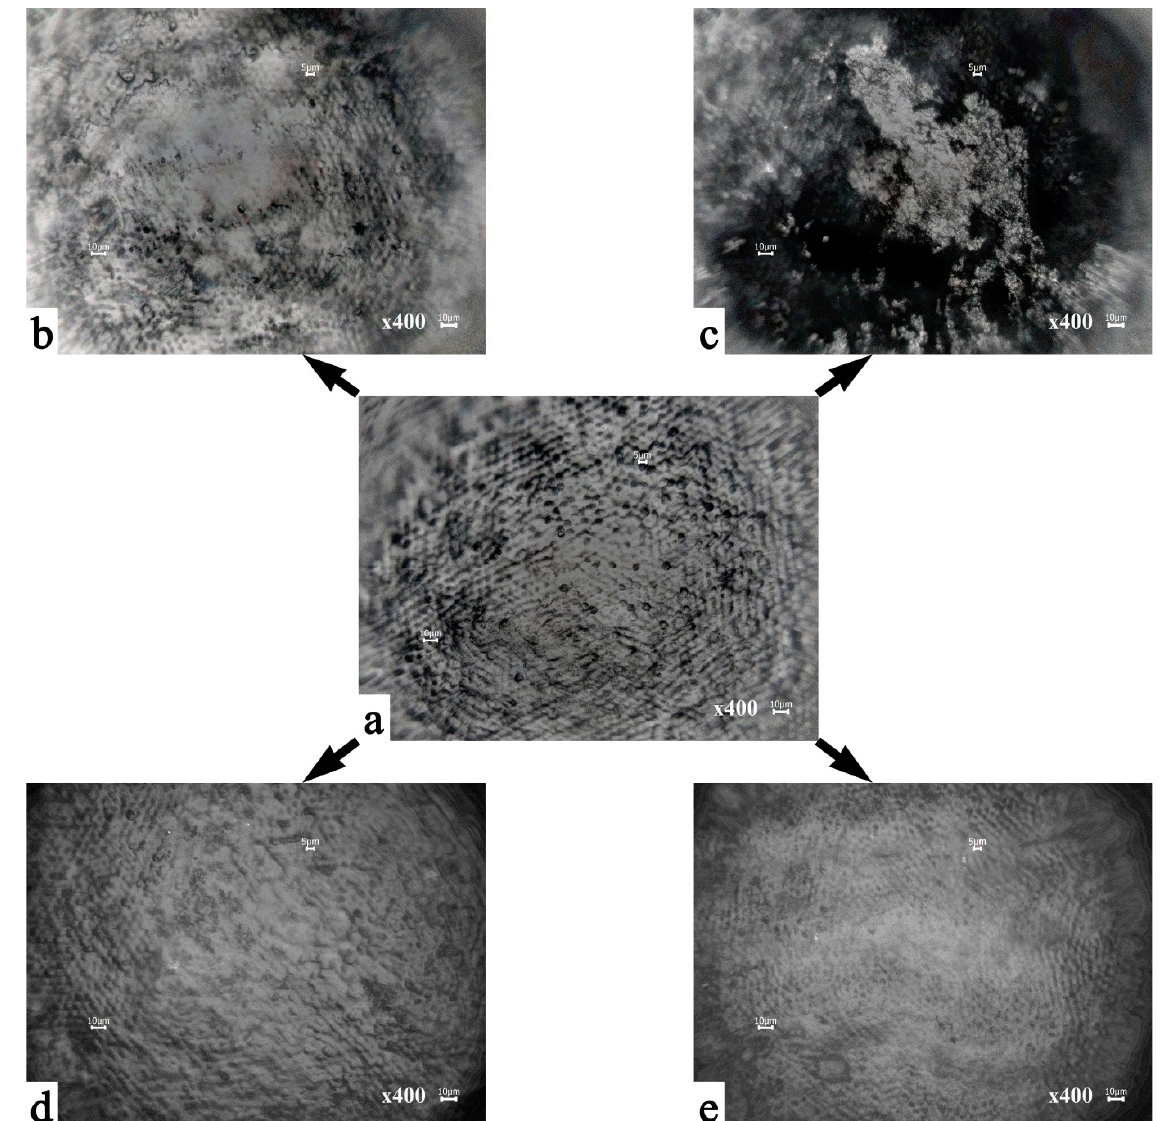
Figure 2. Optical images of the surface areas of the samples: ( a ) healthy tooth enamel without treatment (sample N1); ( b ) without pretreatment and with subsequent mineralization (sample N2); ( c ) after surface pretreatment with H 3 PO 4 and subsequent mineralization (sample N3); ( d ) after surface pretreatment with Ca(OH) 2 and subsequent mineralization (sample N4); ( e ) after surface pretreatment with Ca(OH) 2 and amino acid booster, with subsequent mineralization (sample N5).